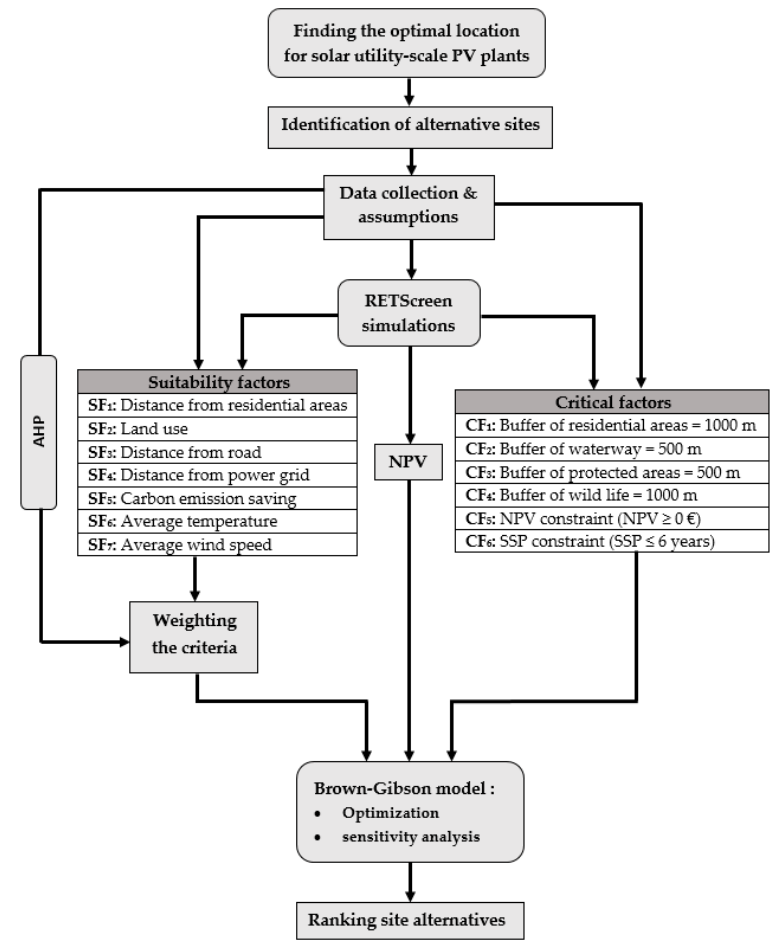
Figure 3. The flowchart of the adopted methodology for the study.